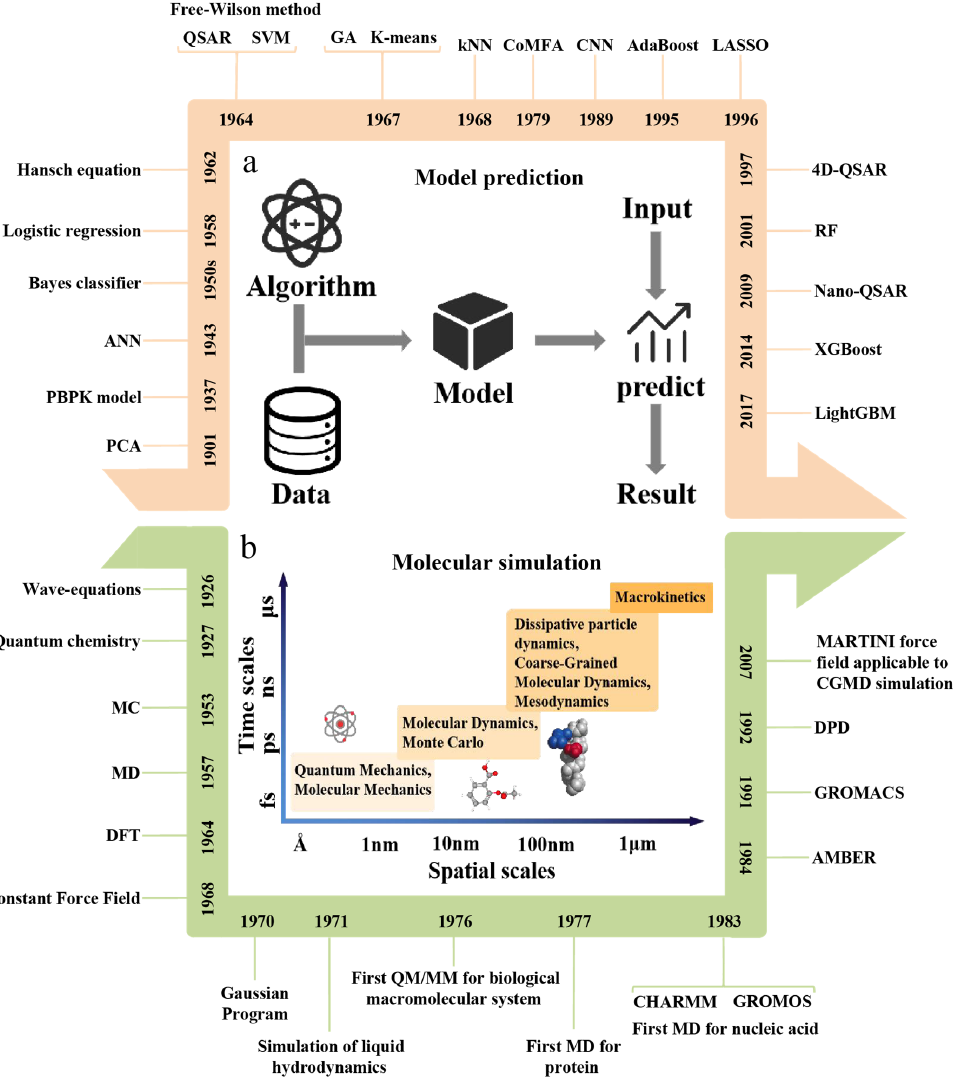
Figure 3. Timeline of relevant developments to predict and simulate the physicochemical properties and biological e ff ects of nanomaterials. ( a ) Schematic of model prediction work fl ow. ( b )